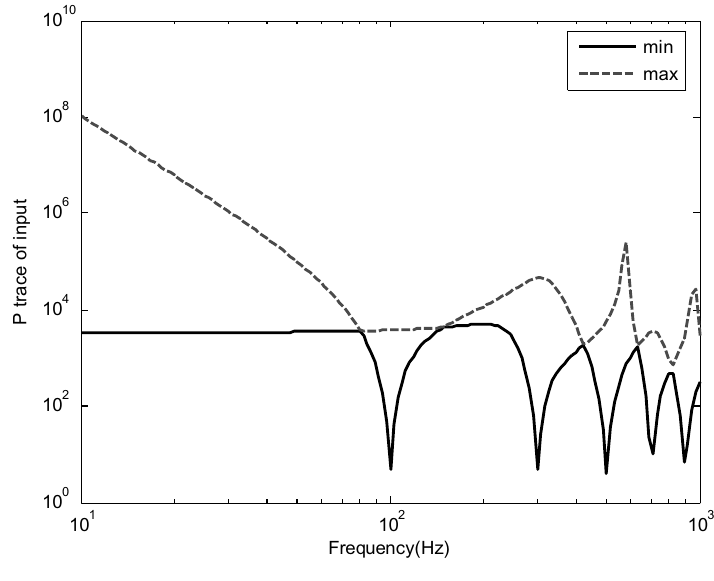
Fig. 11. Example 2, Trace of input spectral